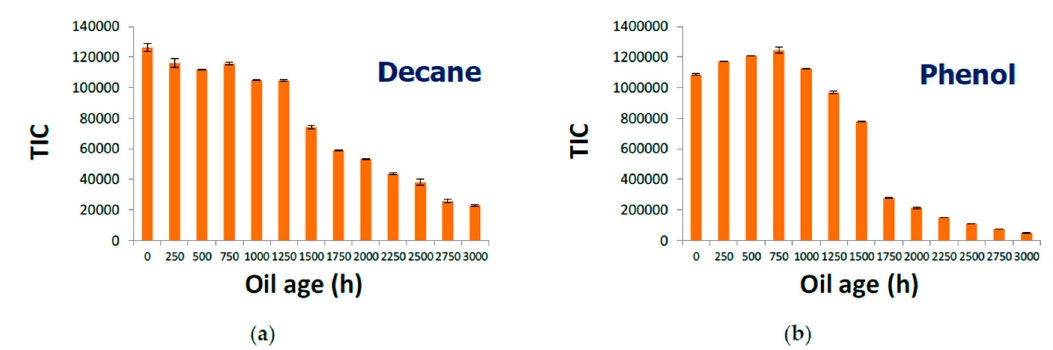
Figure 3. Trend of ( a ) decane and ( b ) phenol as an example of analytes in the oil headspace for samples aged from 0 to 3000 h (step 250 h) derived from SPME-GC-MS measurements at room temperature.